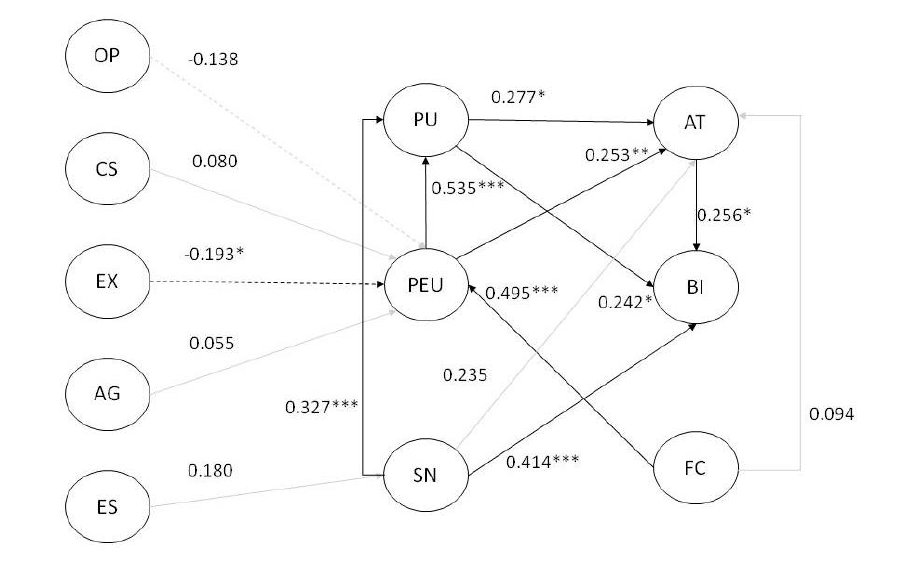
Figure 2. Structural Model (pre-wiki scenario).